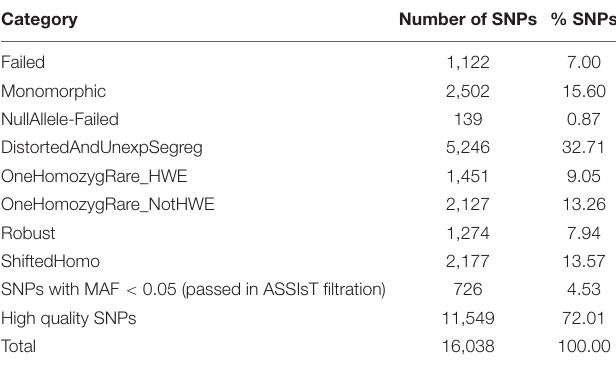
TABLE 1 | SNP classification summary obtained in